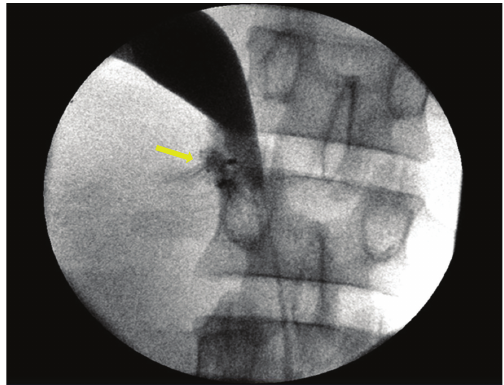
Figure 2: Retrograde ureteropyelogram showing opacification of all the upper urinary tract with extravasation of the contrast material in the ureteropelvic junction